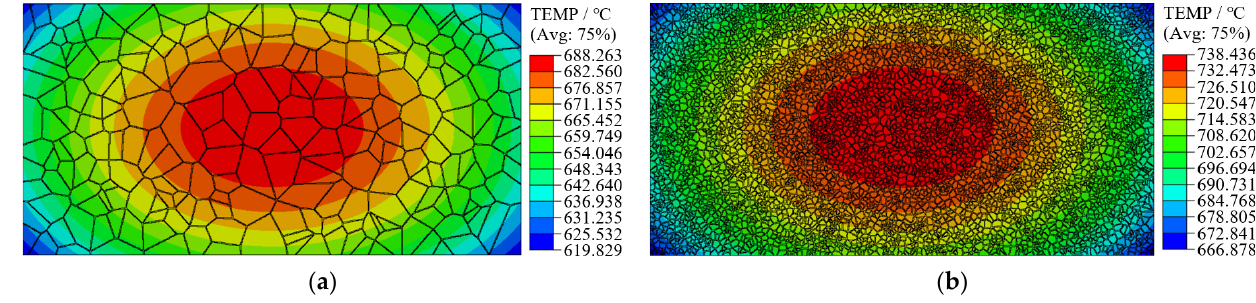
Figure 12. Distribution of temperature in polycrystalline under application of electric current in finite element analysis: ( a ) CG model; ( b ) FG model.